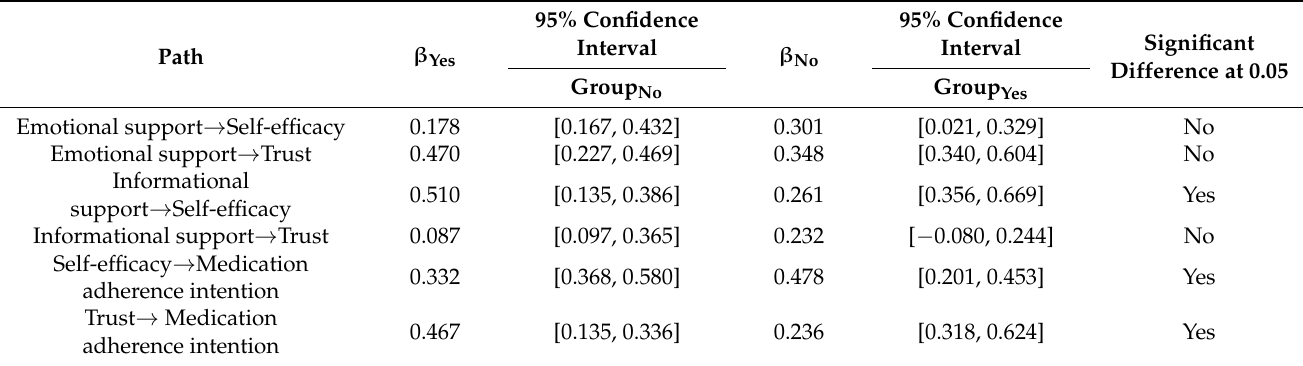
Table 4. Multi-group analysis of online community participation.